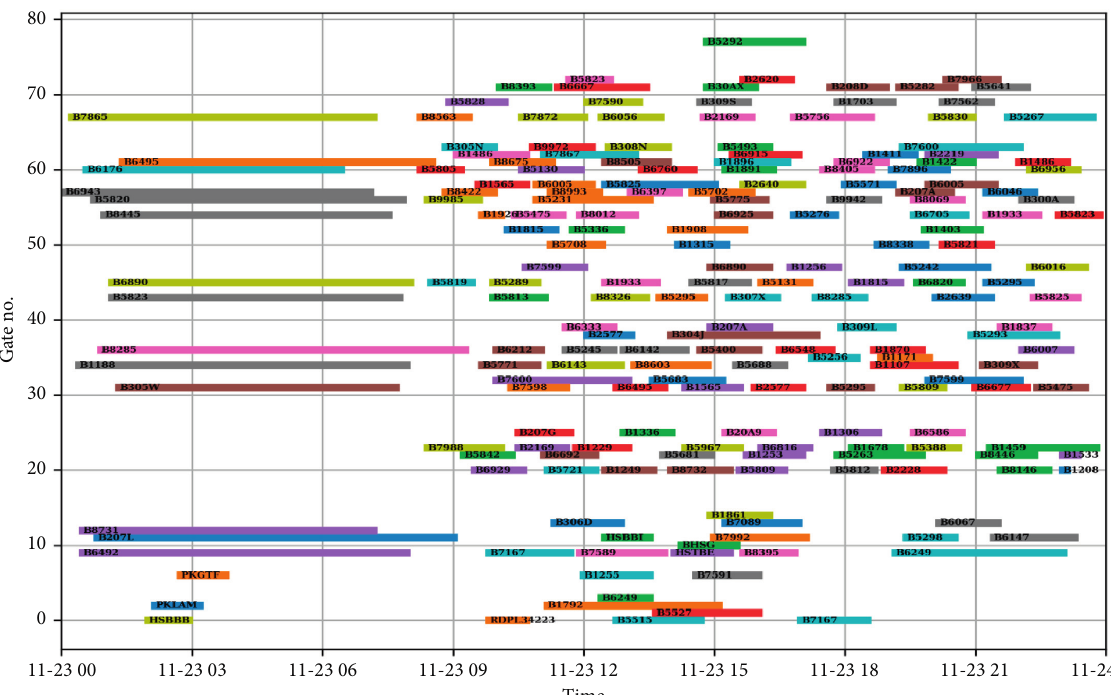
Figure 8: Gantt chart for the result of 200 flights.